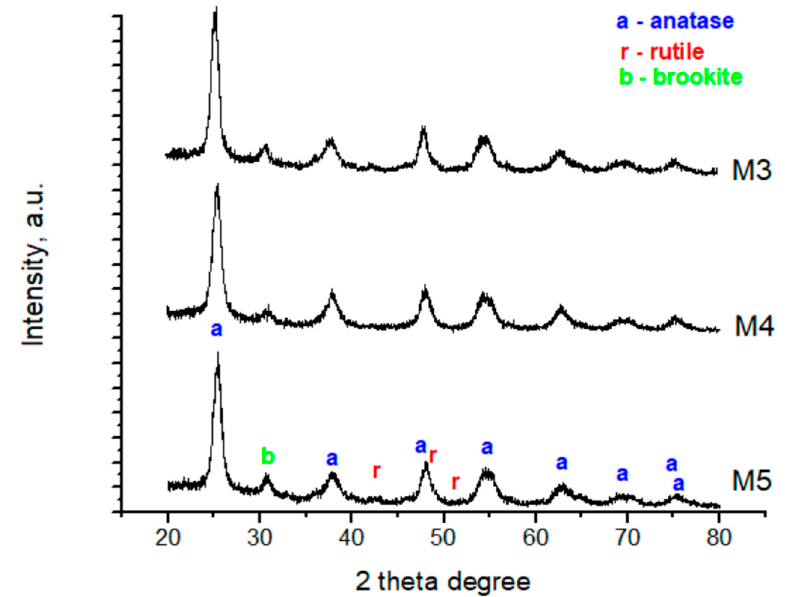
Figure 5. XRD diffractograms for M3, M4, and M5 TiO 2 samples (the identification of rutile, anatase, and brookite phases according JCPDS card no. 01-073-1765, JCPDS card no. 01-089-4203, and JCPDS card no. 29-1360 respectively). Table 3. Structural parameters calculated using XRD patterns of the selected titania samples.